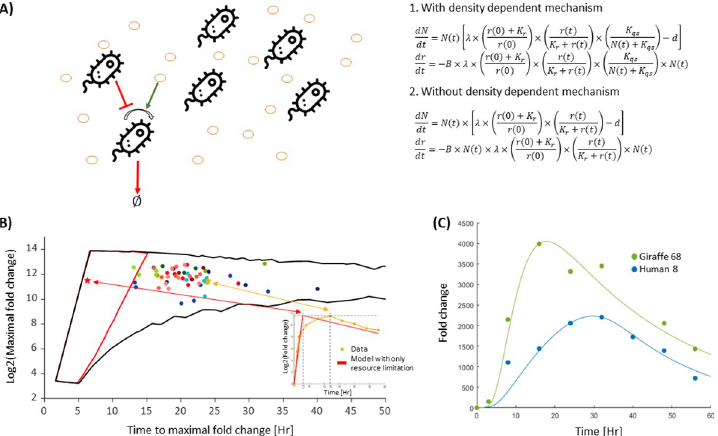
Fig 3. Density-dependent limitation and resource limitation are both necessary to capture the entire growth dynamics. (A) Growth and death dynamics regulation is composed out of two environmental factors and described by two coupled ODEs. The orange circles denote the resource. The resource is needed for bacterial growth (green arrow), and bacterial density negatively affects growth (red arrow). The first two coupled ODEs describe these dynamics and include two growth rate modulators: resource amount and bacterial density. The second pair of ODEs describe bacterial growth dynamics considering only resource limitation. (Bacterium icon made by Freepik from www.flaticon. com). (B) Quantifying the models’ limits. The black lines are the boundaries of the possible values of maximal FC and time to maximal FC from the model that takes both resource limitation and density-dependent (model (1)). The red lines represent the boundaries of the model that accounts only for resource limitation (model (2)). These values are estimated for wide ranges of λ (0.8–1.5), B (10 − 4 –10 − 3 ), K (0–1) and, in the case of model (1), K (10 2 − 10 3 ). The r qs model with only resource limitation cannot capture the experimental data (full colored circles). The inset illustrates an example of an experimental measurement that is outside the resource limitation feasible space (red star). The red curve is the resource limitation model that has the same maximal FC as the data. Note that for a model that accounts only for resource limitation, the time to maximal FC, for a given maximal FC, is much shorter than the observed times. (C) A representative fit of the model with both resource limitation and density-dependent effect on the data. The presented samples are the two samples that were shown in Fig 1A. The fits for all the samples are shown in S5